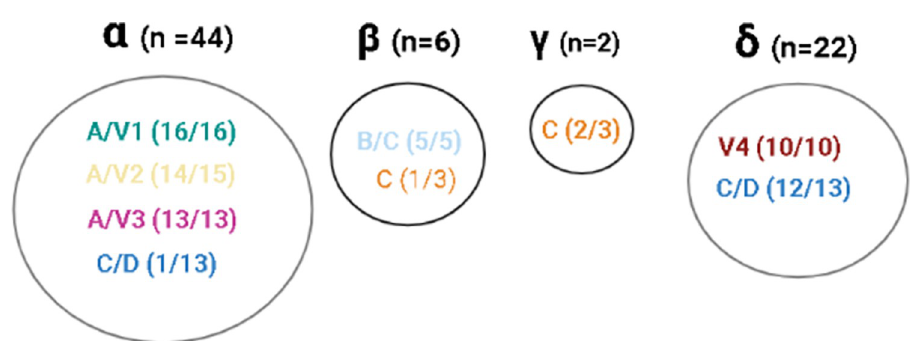
Fig 4. HRP2 haplotype frequency in the Peruvian P . falciparum samples (n = 74). P . falciparum samples were included in their respective lineages previously identified in this study and them were grouped (in circles) in new categories called HRP2 haplotypes ( α , β , γ and δ ) according to HRP2 microsatellite analysis described in Akinyi, S. et al 2013. n = indicates the quantity of samples identified for each HRP2 haplotype (inside the circles, the parenthesis indicates the quantity of samples that corresponds to each linages identified using neutral